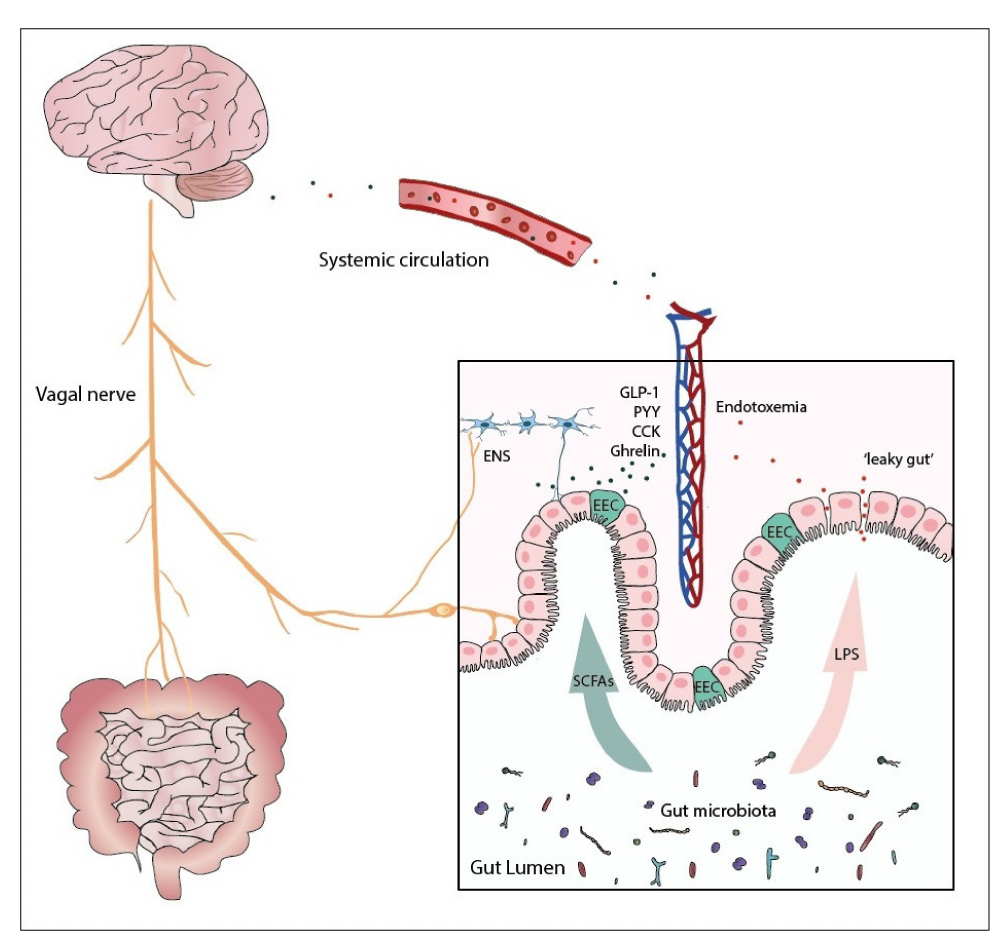
Figure 1. Microbiota–gut–brain axis. The gut–brain axis is a bidirectional pathway that integrates signals from the VN, hormones (e.g., GLP-1, PYY, CCK, ghrelin) secreted from the EECs and signals from the ENS. The microbiota and its metabolites, such as SCFAs, can influence the gut–brain axis through modulating these pathways. Gut permeability due to altered gut microbial composition in obesity leads to LPS leakage and endotoxemia, which in turn can induce peripheral and neuroinflammation. GLP-1, glucagon-like peptide 1; PYY, peptide YY; CCK, cholecystokinin; SCFAs, short-chain fatty acids; LPS, lipopolysaccharide; EEC, enteroendocrine cell; ENS, enteric nervous